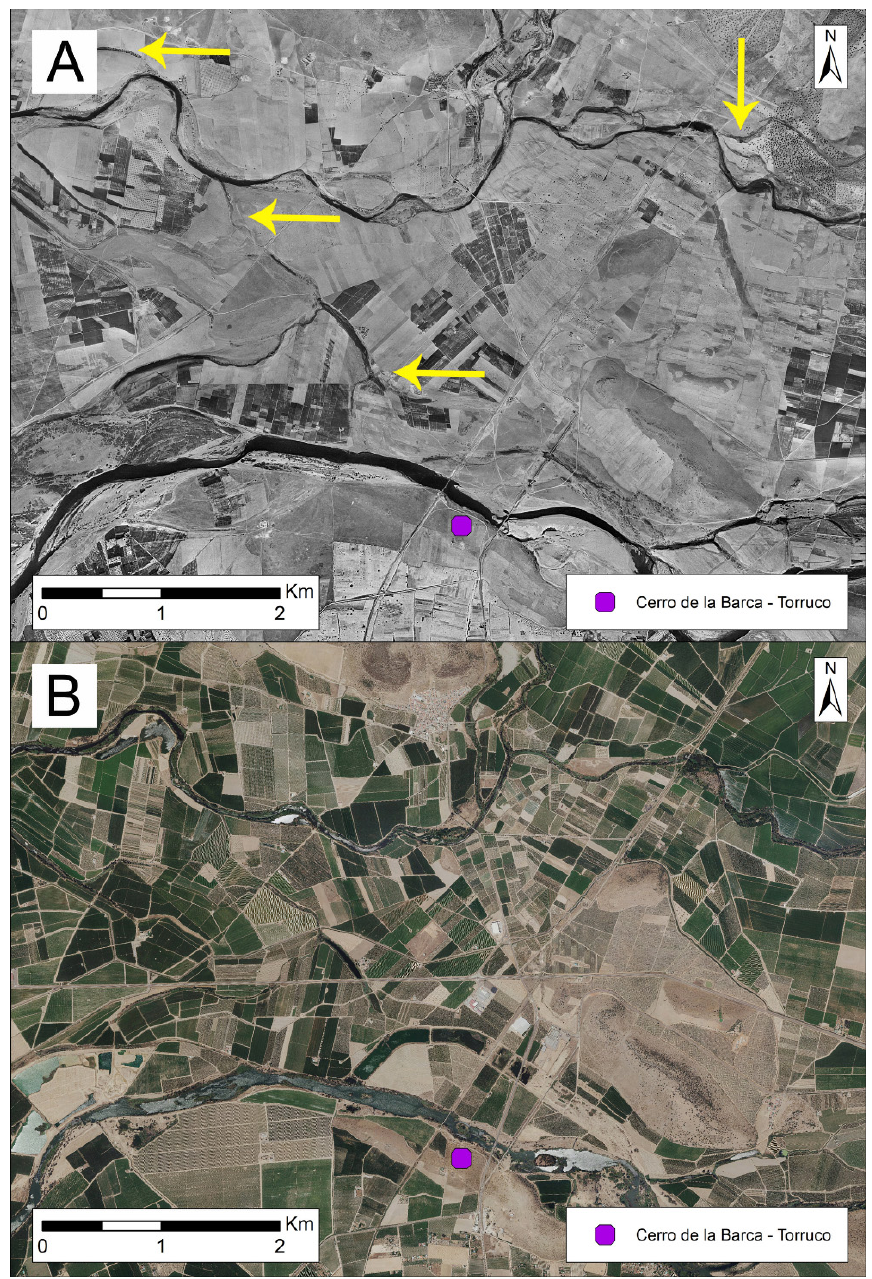
Figure 14. Comparison between the orthophotographs of the American Flight B, made between 1956/1957 ( A ) and the PNOA Máxima Actualidad ( B ) of the territory that extends to the north of the village of Cerro de la Barca (Villanueva de la Serena, Badajoz, Spain). It shows how some branches of the Guadiana have dried out.